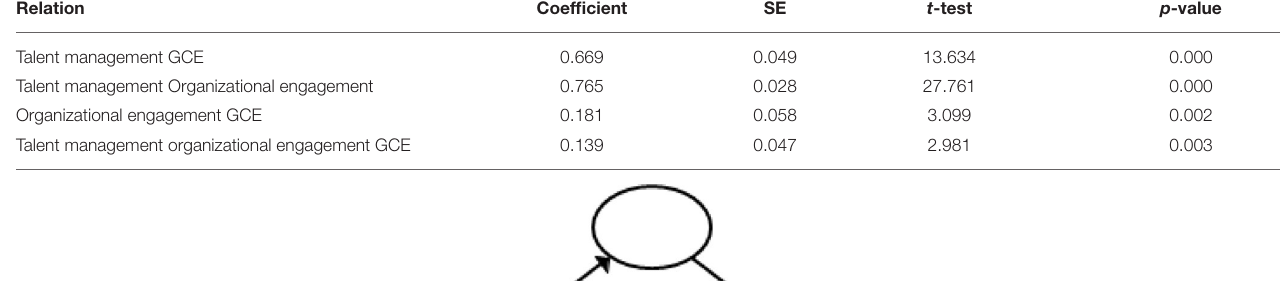
TABLE 4 | Structural model.